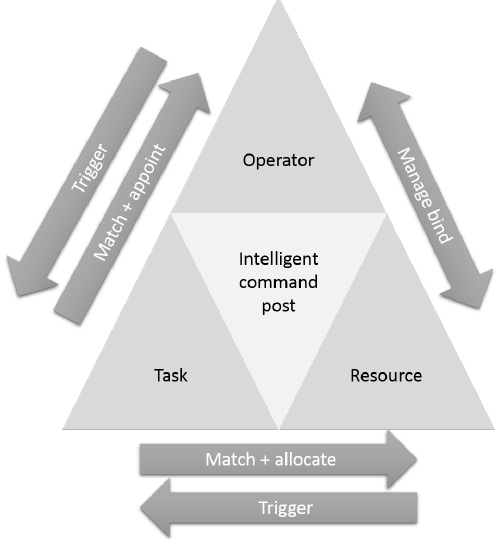
Figure 4. The design of connections between resources, users and tasks is the key to the design of intelligent interaction